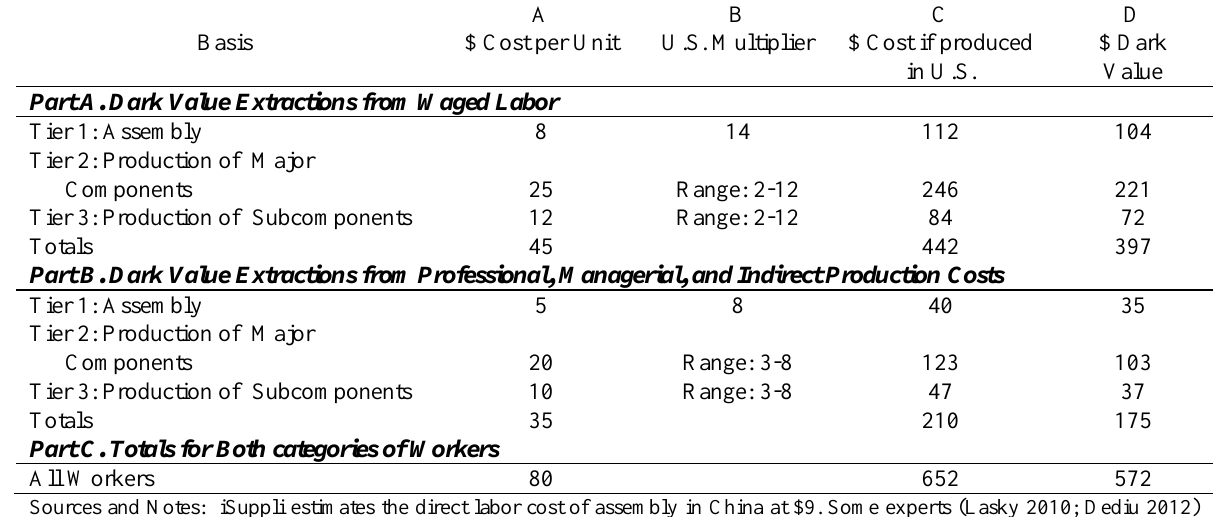
Table 3. Partial Accounting of Dark Value in the First Generation iPad Supply Chain, January 2010 - March 2011 Basis